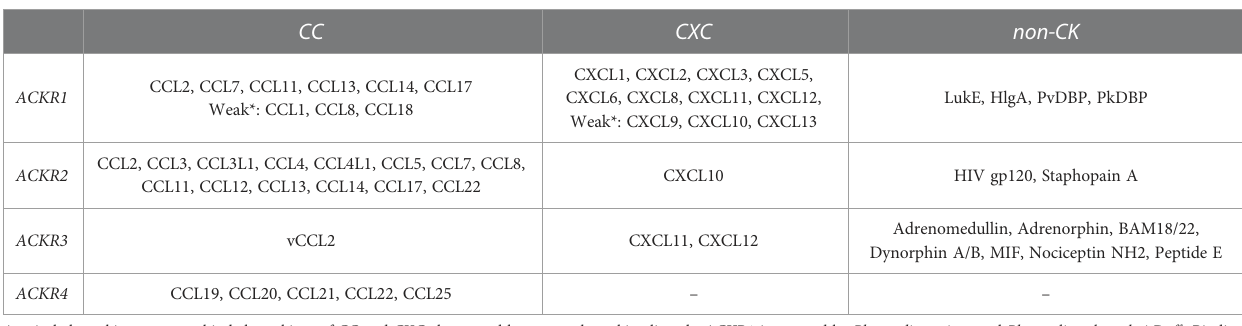
TABLE 1 Ligands of atypical chemokine receptors